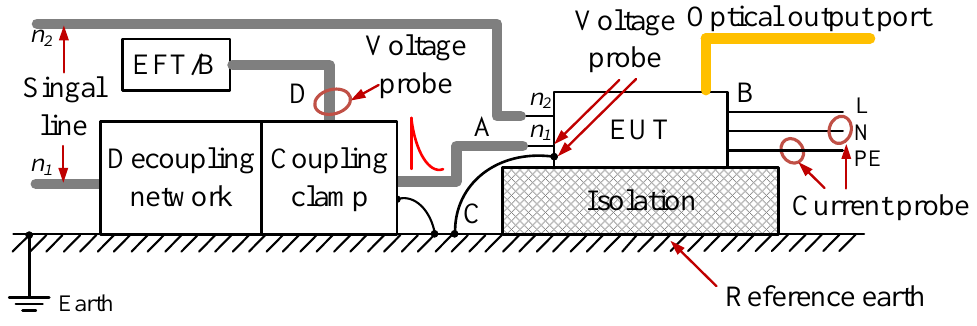
Figure 5. Test setup of di ff erent grounding configurations under EFT / B coupling on the signal line.